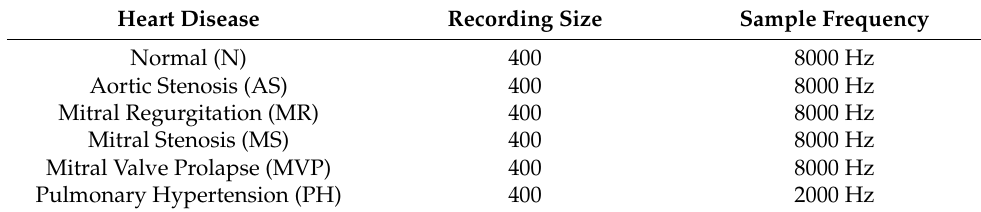
Table 3. Recording distribution after data